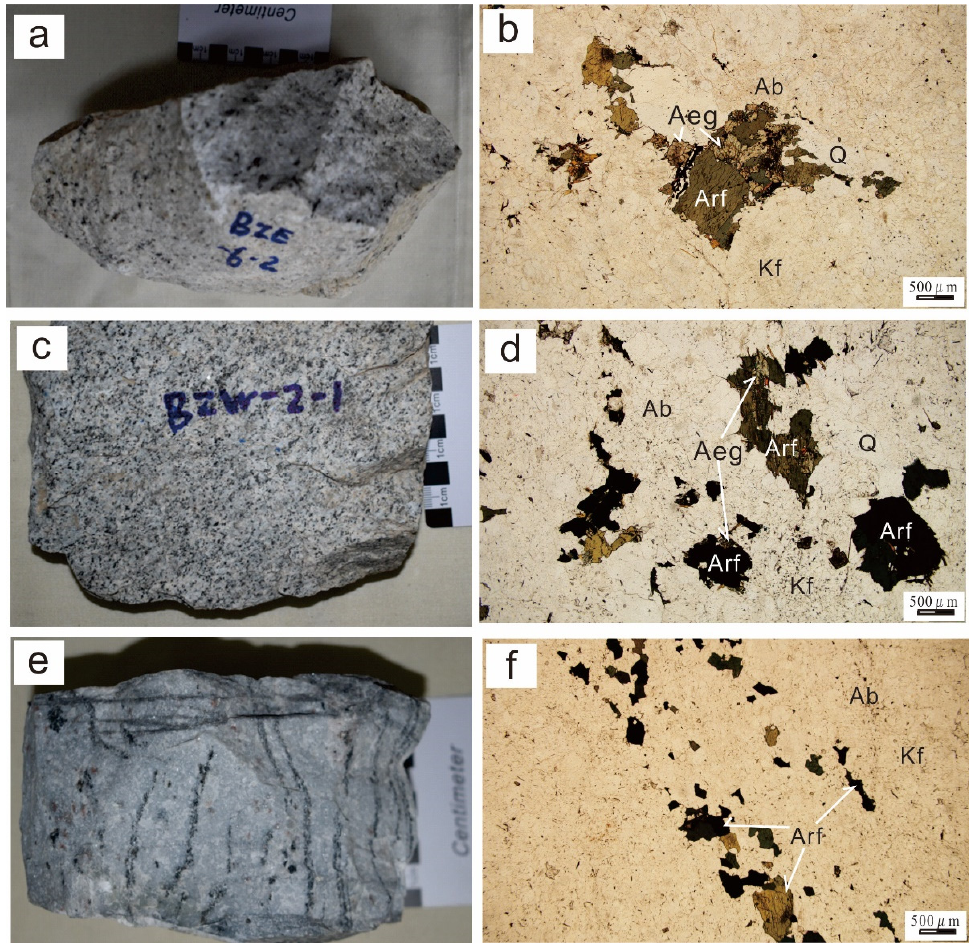
Figure 3. Hand sample images and microphotographs of main rocks of the Boziguoer intrusion. ( a , b ) = Alkalic granite facies; ( c , d ) = syenite facies I; ( e , f ) = syenite facies II. Abbreviations: Q = quartz, Ab = albite, Kf = K-feldspar, Aeg = aegirine, Arf = arfvedsonite.